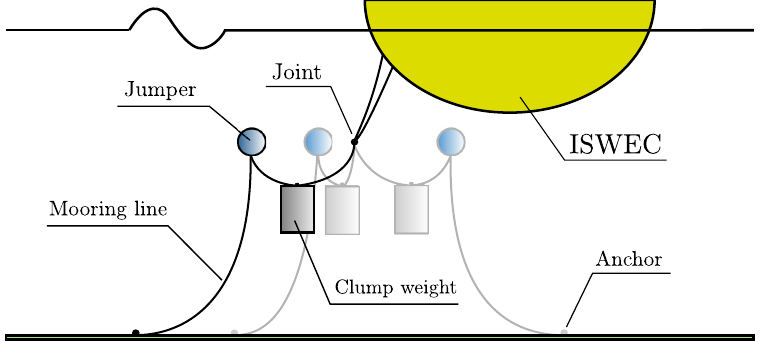
Figure 3. ISWEC mooring